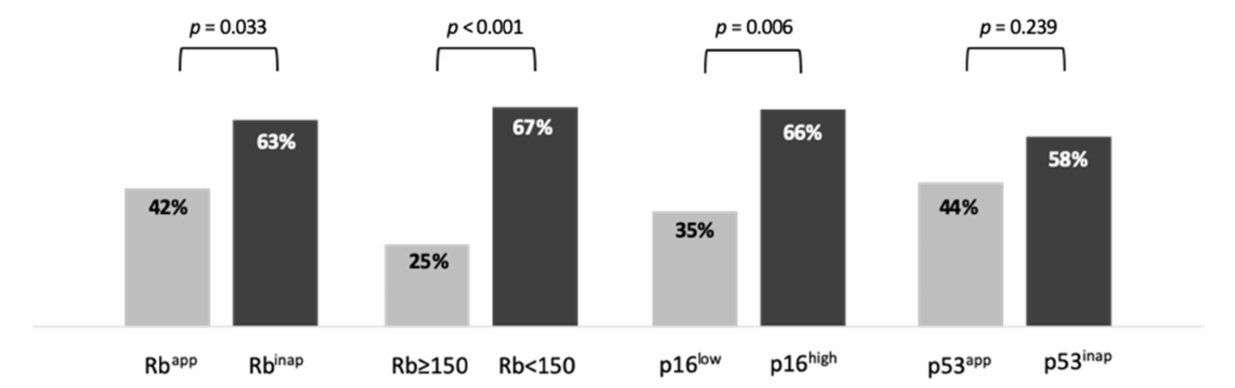
Figure 4. Response rate depending on biomarker